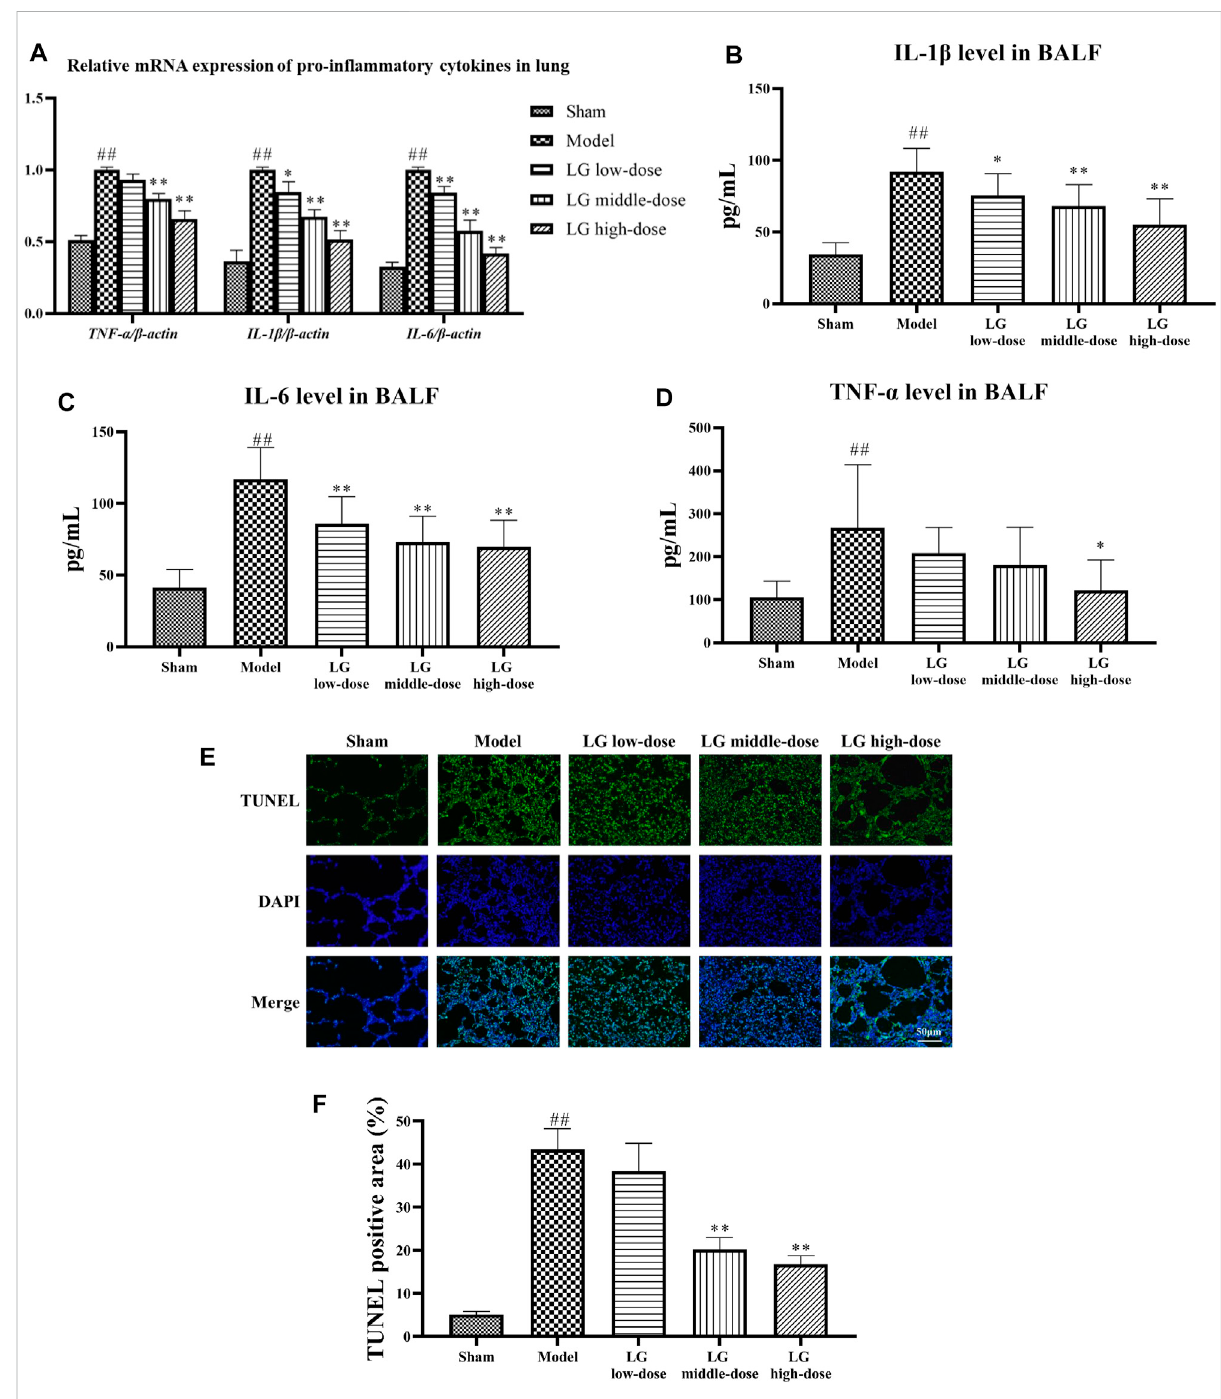
FIGURE 3 LG treatment reduced the in fl ammatory response and apoptosis in lung. (A) qPCR showed that LG treatment down-regulated the mRNA expressionof IL-6 , IL-1 β ,and TNF- α inlung. (B – D) LGtreatmentdecreasedthelevelsofIL-1 β (B) ,IL-6 (C) andTNF- α (D) inBALF. (E,F) TUNELstaining indicated that LG treatmentdecreased the proportions ofapoptotic cells in lung (100×). TUNEL: terminal deoxynucleotidyl transferase deoxyuridine triphosphate (dUTP) nick end labeling. Sham group (n = 15), Model group (n = 8), LG low-dose group (n = 9), LG middle-dose group (n = 9), LG high-dose group (n = 10) ##: p < 0.01 compared with the sham group; *: p < 0.05 compared with the model group; **: p < 0.01 compared with the model